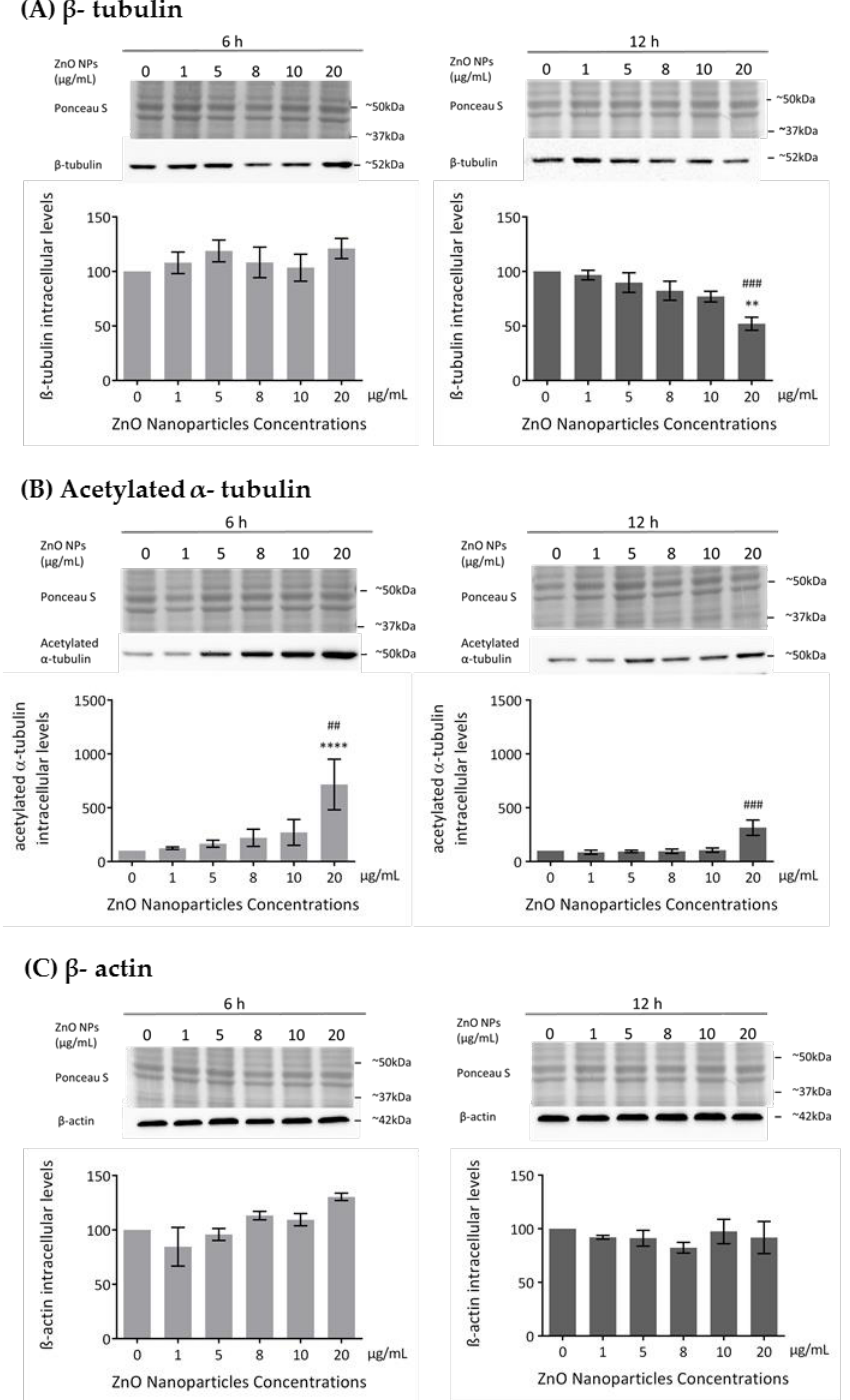
Figure 5. InfluenceofZnONPsincytoskeletonstructureanddynamicsofGC-1spgcells: ( A )Quantification Figure 5. Influence of ZnO NPs in cytoskeleton structure and dynamics of GC-1 spg cells: ( A ) of β -tubulin, ( B ) acetylated α -tubulin, ( C ) β -actin protein levels in GC-1 cells by immunoblotting Quantification of β-tubulin, ( B ) acetylated α-tubulin, ( C ) β-actin protein levels in GC-1 cells by analysis. Cells were exposed to ZnO NPs for 6 h and 12 h. Protein levels are presented as a fold change immunoblotting analysis. Cells were exposed to ZnO NPs for 6 h and 12 h. Protein levels are (%) over controls, which was plotted as mean ± SEM of three or four independent experiments. * For presented as a fold change (%) over controls, which was plotted as mean ± SEM of three or four comparisons between concentrations and time points, two-way ANOVA was used. # For comparisons independent experiments. * For comparisons between concentrations and time points, two-way between concentrations, one-way ANOVA was used. ** / ## p < 0.01. ### p ≤ 0.001. **** p < ANOVA was used. # For comparisons between concentrations, one-way ANOVA was used.